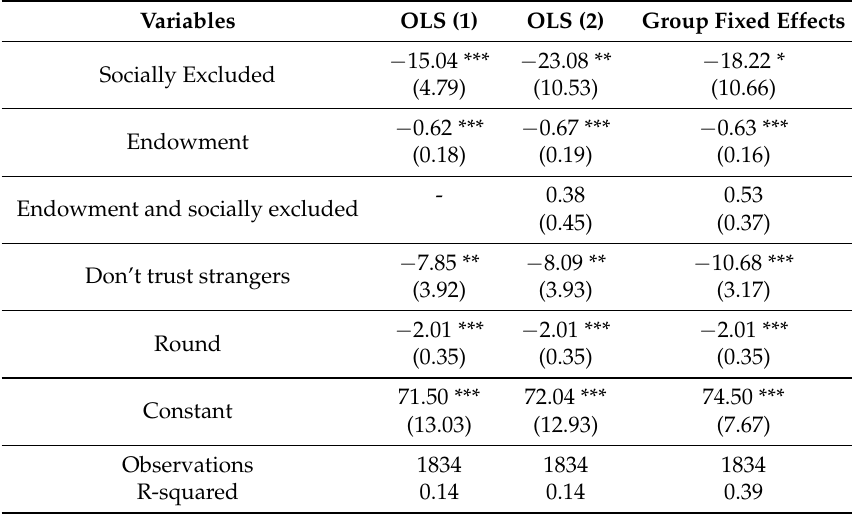
Table 6. Effects of Individual Social